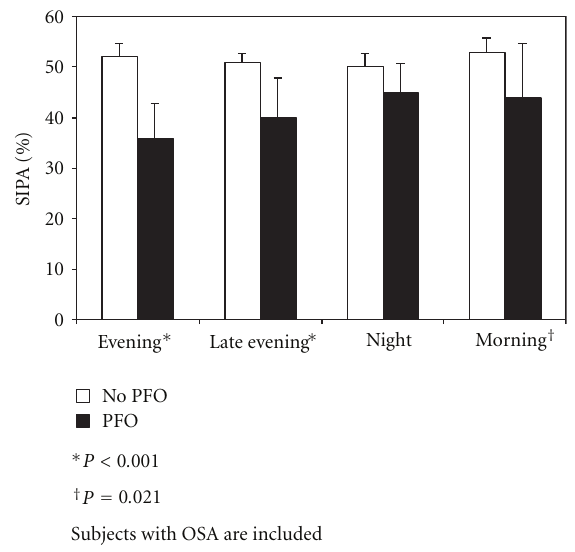
Figure 2: SIPA in subjects with and without PFO.